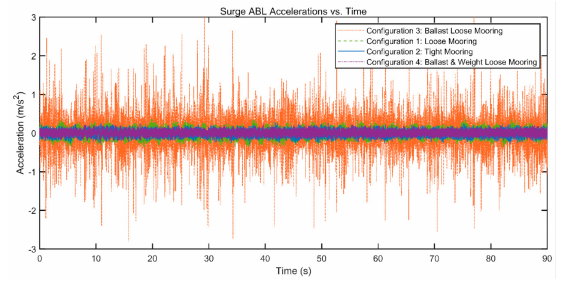
Figure A2. ABL wind surge accelerations for all configurations.